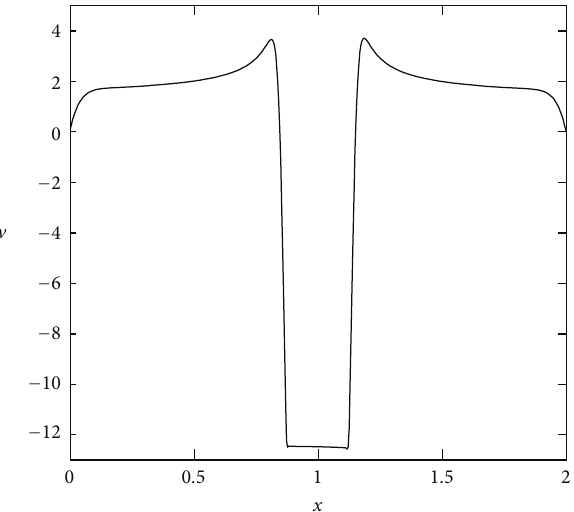
Figure 3: 2D cut of v component of velocity at time t = 0 . 3.